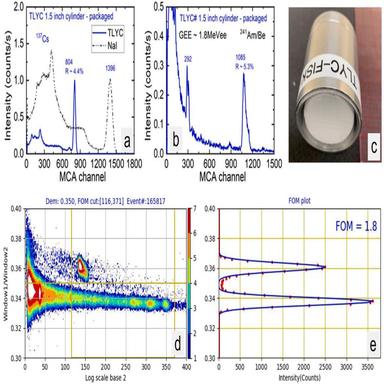
Characterization of a ∅1.5″ × 1″ TLYC sample, encapsulated in a permanently sealed can as a dual mode detector. (a) 137Cs spectra collected with 1 μs amplifier shaping time. (b) Energy equivalent Am-Be spectra collected with 1 μs amplifier shaping time. (c) Polished crystal. (d) PSD scatter plot created using the waveforms generated by thermalized Am-Be neutron source in the TLYC crystal. (e) Projection of the events in region in the scatter plot results in FOM of 1.8.